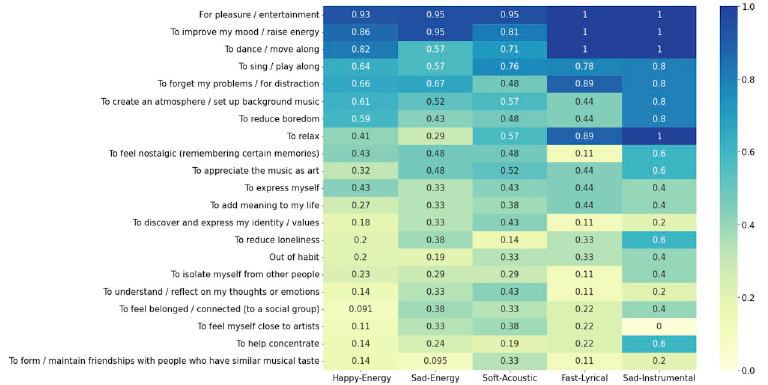
Fig 4. The distribution of participants’ ratings of individual RL items associated with their subgroups of dance music. To relate subgroups of dance music with RL, ratings of the individual RL dance items were plotted as percentages for each of the 5 subgroup of dance music ( N = 100) as a